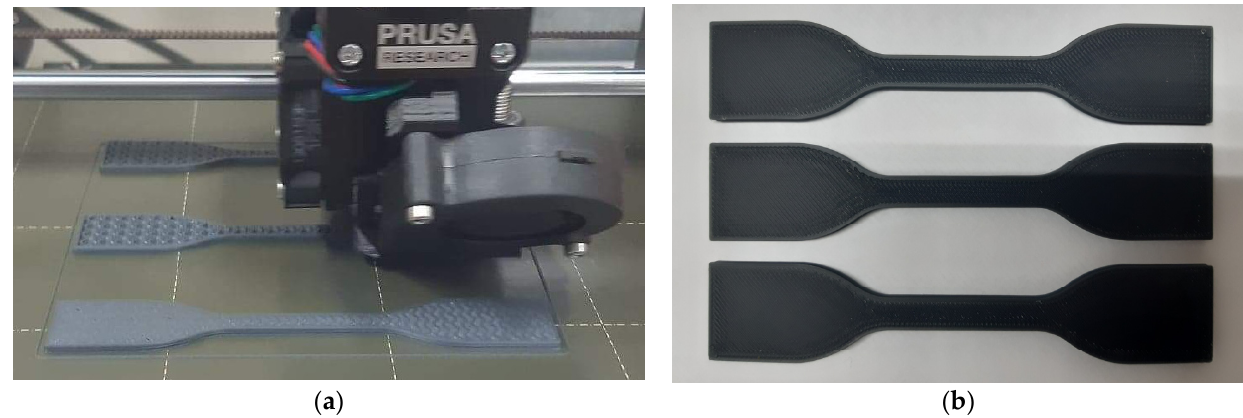
Figure 12. ABS tensile specimen during printing ( a ) and printed PLA tensile specimen ( b ), both with 2% graphite and an infill of 80%.